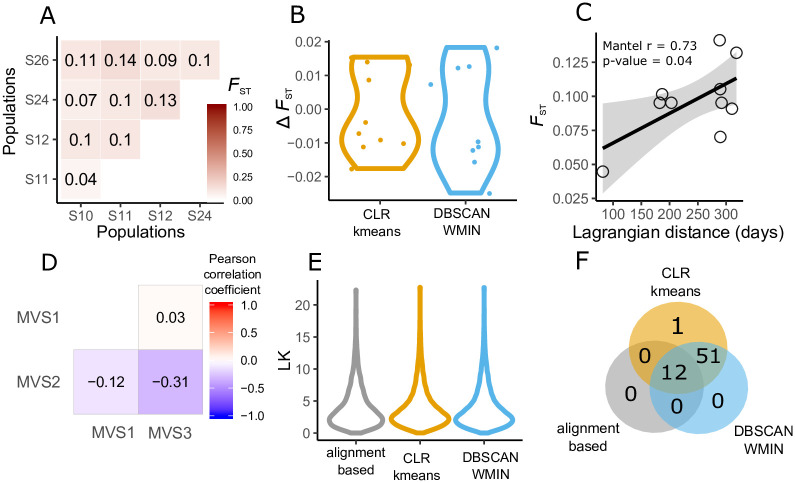
Examples of applications and accuracy of metavariant species.A. Genomic differentiation based on pairwise FST of O. nana populations from the MVS built with DBSCAN-WMIN. B. Difference of FST values between alignment-based method and MVSs. C. Mantel test with Lagrangian distances. D. Co-differentiation between species. E. LK distribution. F. Venn diagram of loci predicted under selection (LK p-value ≤ 0.001) by the different approaches.